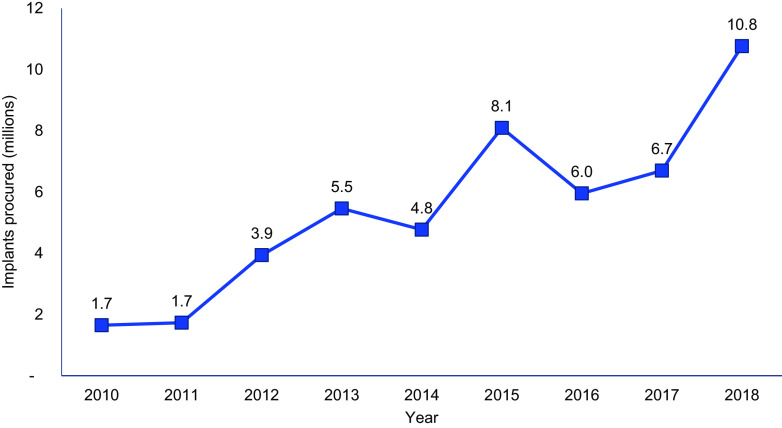
Implant Procurement for FP2020 Countries, 2010–2018aa These data were sourced from United Nations Population Fund Reproductive Health Interchange on July 1, 2019. Data are provided by the central procurement offices of large family planning donors, institutional buyers, and other organizations that procure contraceptives. The data reflect ∼80% of donor-provided contraceptive supplies and do not include directly procured products by governments. More information is available at: https://www.unfpaprocurement.org/rhi-home.